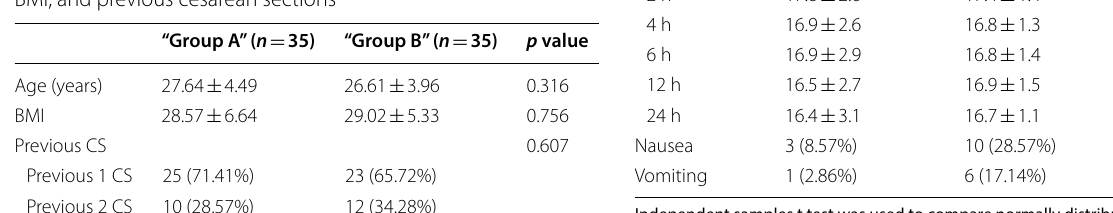
Table 1 Comparisons between the two groups regarding age,